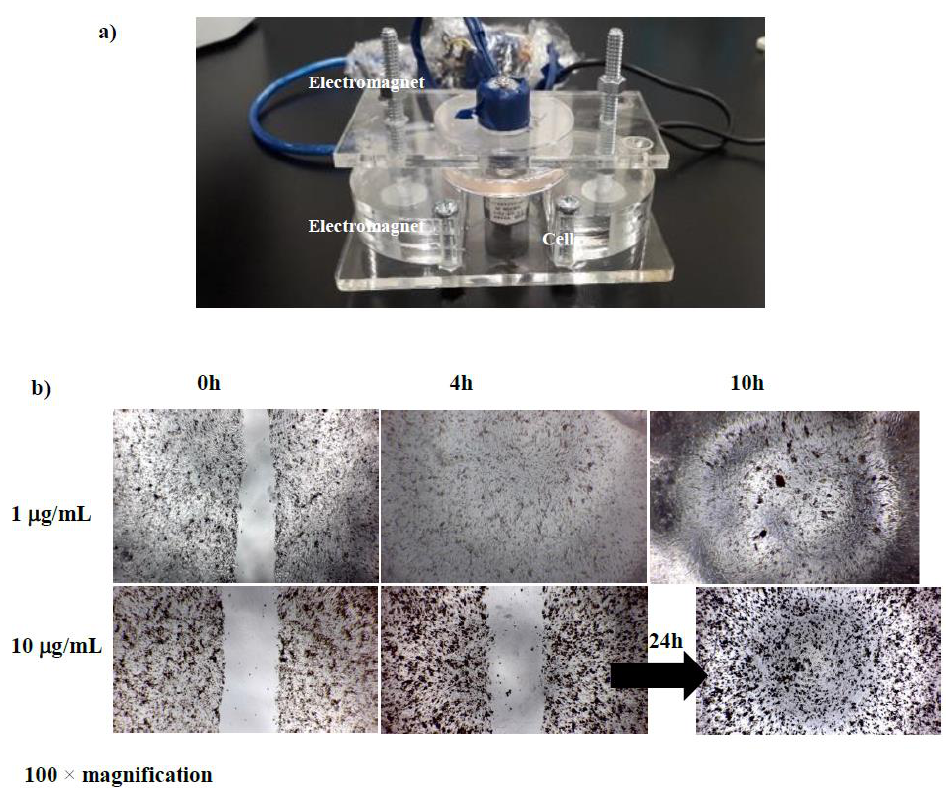
Figure 6. ( a ) The magnetic device used in this experiment; ( b ) cell migration assay of BCECs containing different concentrations of D-SPIONs under a gradient magnetic field.